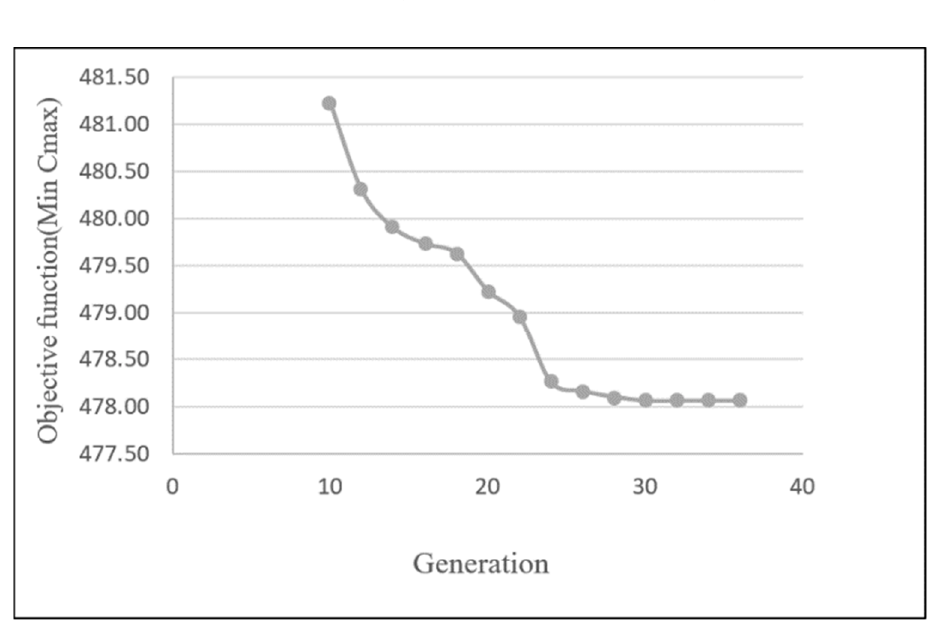
Figure 9. HGAG behavior using different population sizes. Process cooperation in HGAG To perform an analysis on the cooperation of the processes in the grid, the following elements are used: 5 RFFS_SDST_ {20, 40, 60, 80, 140} test instances, six groups of cores (5,